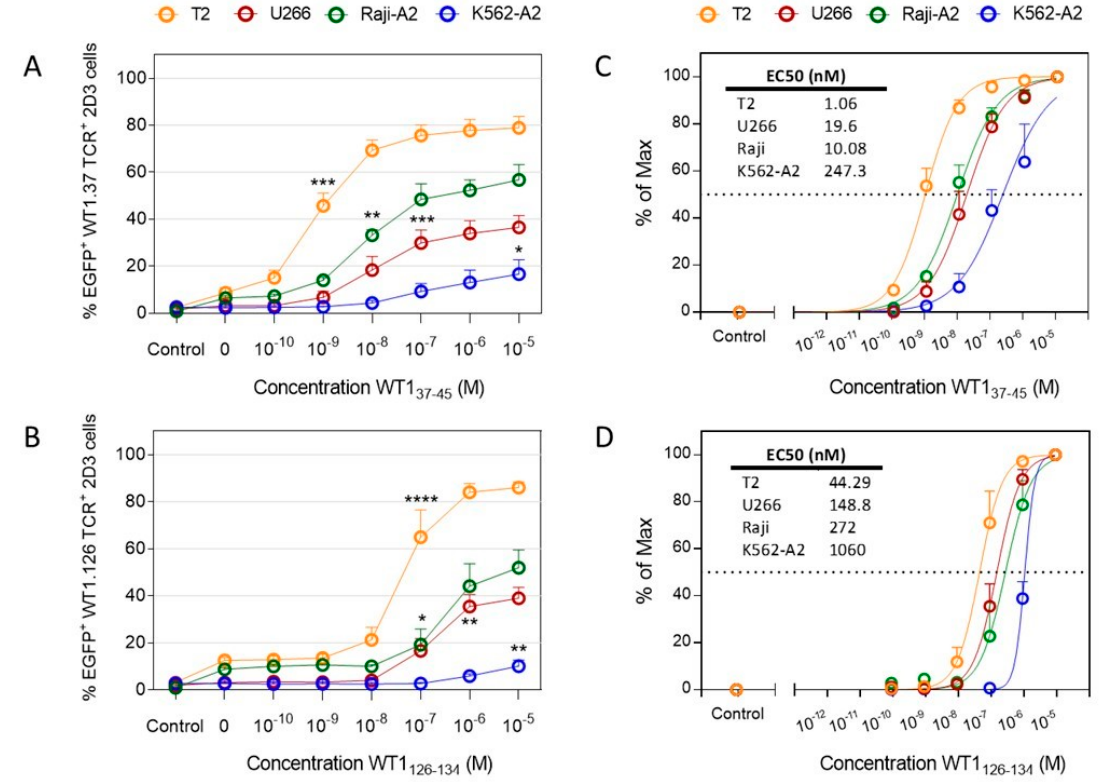
Figure 2. Epitope-specific T-cell activation by four model APC lines. Epitope-specific TCR activation was measured by expression of EGFP after WT1 37–45 ( A , C ) or WT1 126–134 ( B , D ) peptide-specific TCR-transfected 2D3 cells were cultured for 18–22 h with model APCs T2, U266, Raji-A2 or K562-A2 cells that were pulsed with decreasing concentrations of WT1 peptide. Control depicts unstimulated 2D3 cells only. Graphs show the results of three to five independent replicates, showing ( A , B ) mean % ( ± SEM) of EGFP positive cells and ( C , D ) % of maximal EGFP expression ( ± SEM). ( A , B ) Data were analyzed using one-way ANOVA followed by Dunnett’s post hoc test (comparing to non-peptide pulsed cells). EC50, the concentration of WT1 peptide at which 50% of the maximal EGFP expression is reached. *, p < 0.05; **, p < 0.01; ***, p < 0.001; and ****, p < 0.0001.